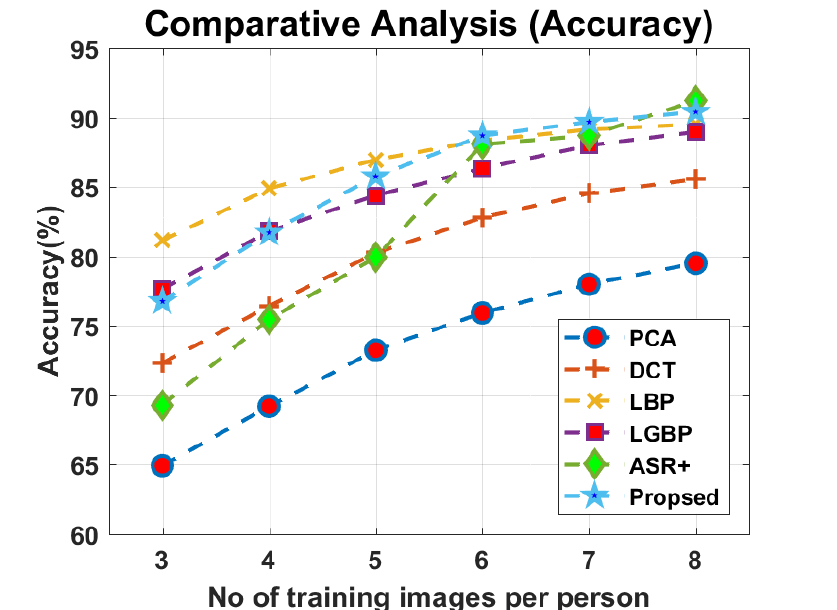
Figure 16. Comparative analysis on